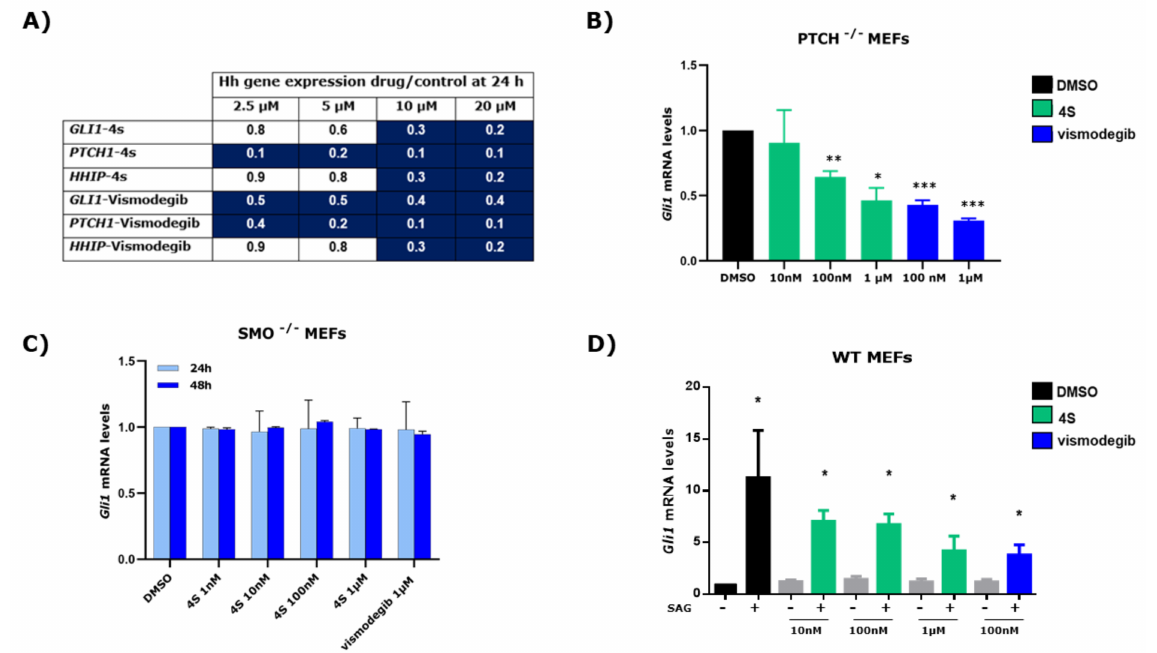
Figure 4. Effect of 4s on the expression of HH target genes. ( A ) Heat map of mRNA levels in human colon cancer HT29 cells as determined by qRT-PCR for a 3-gene HH signature. All values are ratios of experimental over control (treated only with DMSO) data, having previously normalised individual gene expression Ct values to those of housekeeping genes. Samples treated with drugs were collected 24 h after treatment. Expression changes are highlighted as follows: Blue: repression ≤ 0.5. White: no gene repression with values near 1. Results were obtained from three independent experiments and expressed as the mean ± the standard deviation. ( B ) Gli1 mRNA levels in Ptch − / − KO cells treated with 4s for 24 h. Vismodegib was used as a control. mRNAs were extracted and Gli1 mRNA levels were determined by qRT–PCR and normalised to the endogenous Hprt control. Data are presented as the mean ± SD of three independent experiments. (*) p < 0.05, (**) p < 0.01, (***) p < 0.001 vs. DMSO (vehicle). Data were analysed with a parametric t -test. ( C ) Gli1 mRNA levels in Smo − / − MEF cells treated with 4s for 24 h and/or 48 h. Vismodegib was used as a control. mRNAs were extracted and Gli1 mRNA levels were determined by qRT–PCR and normalised to the endogenous Hprt control. Data are presented as the mean ± SD of three independent experiments. ( D ) Gli1 mRNA levels in WT MEFs treated for 24 h with DMSO or SAG 200 nM in presence or absence of compound 4s at the indicated concentrations. Vismodegib was used as a control. mRNAs were extracted and Gli1 mRNA levels were determined by qRT–PCR and normalised to the endogenous Hprt control. Data are presented as